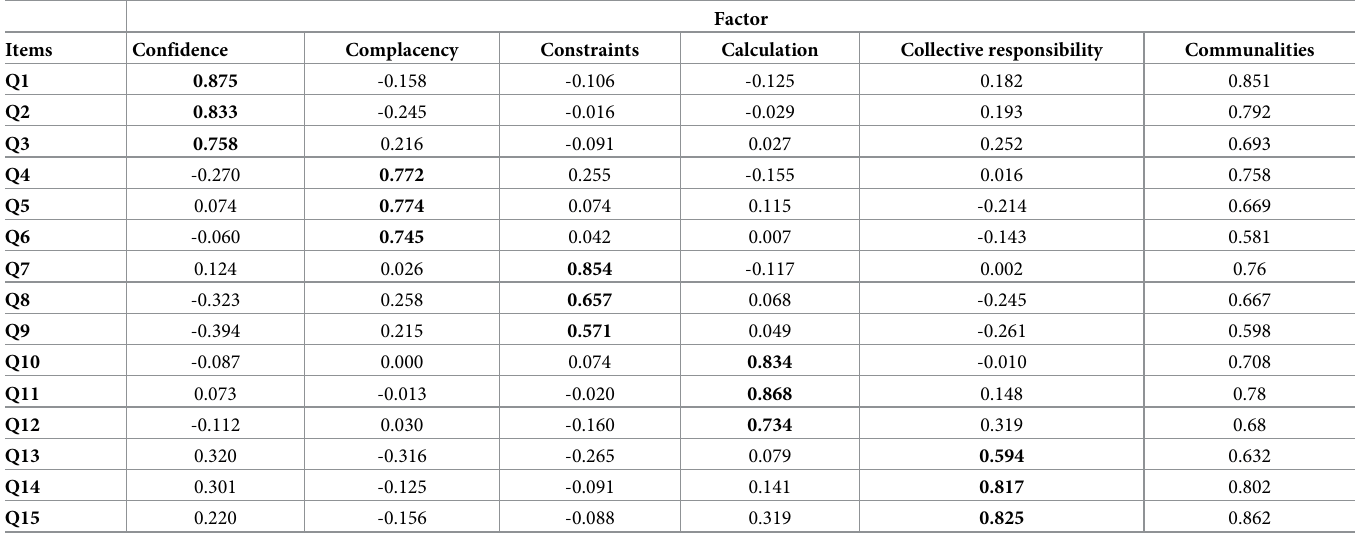
Table 5. Factor loadings of the Arabic version of 5C scale.